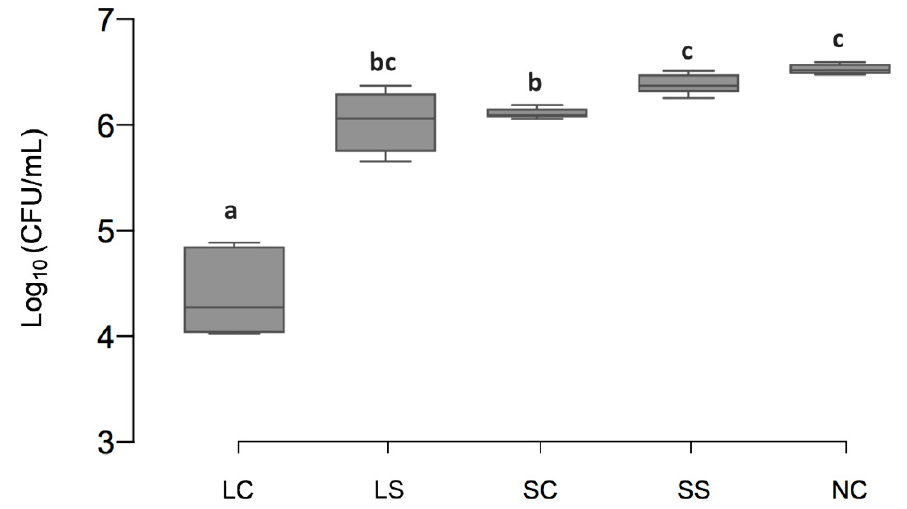
Figure 2. The total amount of viable bacteria. Line and box = median and 25th / 75th percentiles; error bars = minimum and maximum. LC: L. reuteri whole culture; LS: L. reuteri culture supernatant; SC: S. oligofermentans whole culture; SS: S. oligofermentans culture supernatant; NC: negative medium control. Different superscript letters indicate statistically significant differences between groups ( p < 0.05); if boxes share minimum one letter there was no significant difference detected ( p > 0.05).